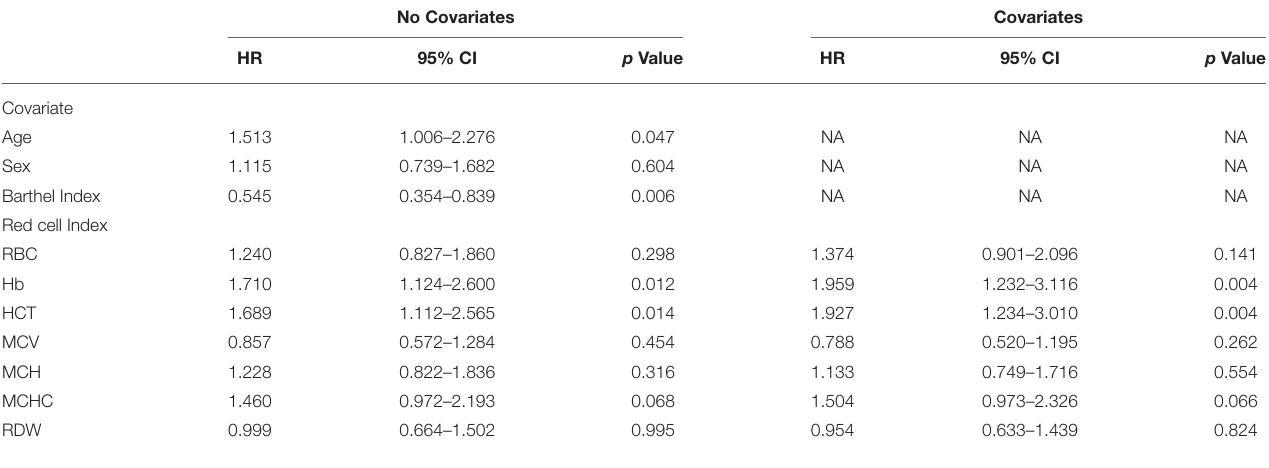
TABLE 3 | Cox proportional hazard models of the associations between red cell indices and